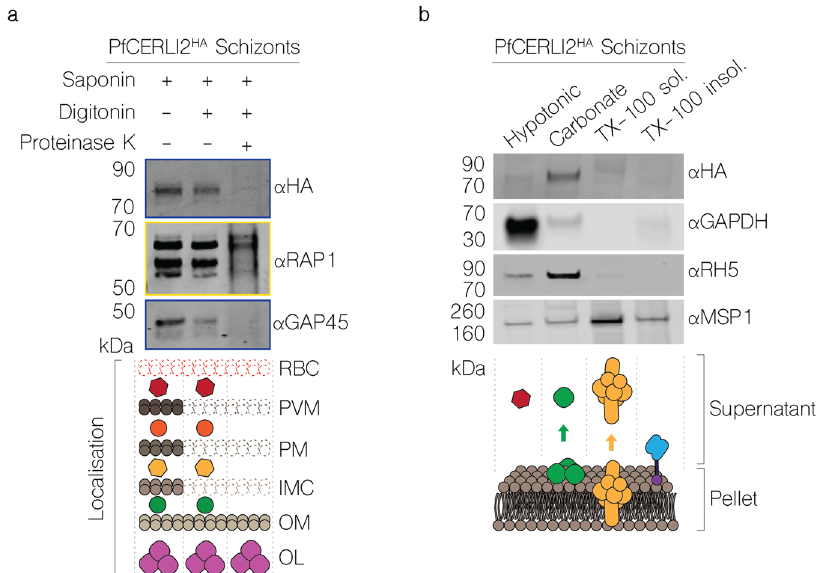
Fig. 5 PfCERLI2 is peripherally associated with the cytosolic face of the rhoptry bulb membrane. a PfCERLI2 HAGlmS Schizont lysates were treated with either saponin alone, saponin and digitonin, or saponin, digitonin, and proteinase K. Saponin lyses the RBC membrane and PVM, while digitonin lyses the parasite plasma membrane but leaves the membrane of internal organelles intact. Treated lysates were then probed with a cocktail of anti-HA (PfCERLI2) and anti-GAP45 (inner-membrane complex, exposed to cytosol) antibodies (outlined in blue) or RAP1 (rhoptry bulb lumen) antibodies (outlined in yellow). Antibodies against RAP1 and GAP45 serving as negative and positive controls, respectively, for proteinase K digestion. Images representative of 3 independent experiments. RBC = RBC membrane, PVM = PV membrane, PM = parasite plasma membrane, IMC = inner-membrane complex, OM = organellar membrane, OL = organelle lumen. b PfCERLI2 HAGlmS schizont lysates were subjected to differential lysis and solubilisation to determine the membrane solubility of PfCERLI2. Lysates were fi rst hypotonically lysed, before being treated sequentially with sodium carbonate and triton-x-100. The supernatant was collected following each treatment, along with a fi nal triton-x-100 soluble fraction. Each fraction was then probed with anti-HA (PfCERLI2), anti-GAPDH (cytosolic), anti-RH5 (peripheral) and anti-MSP1 (GPI-anchored) antibodies. Images representative of 3 independent